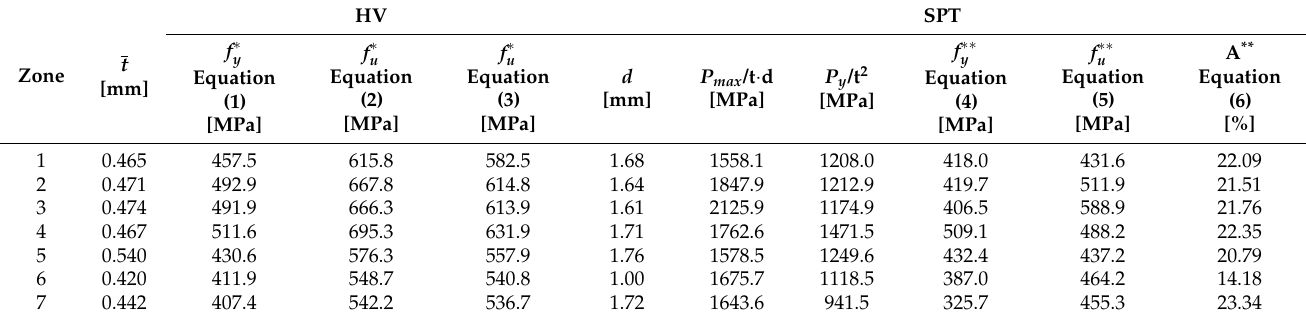
Table 10. Thickness, SPT results, and estimated properties through HV (*) and SPT (**) of the T10 M20 4.8 specimen.